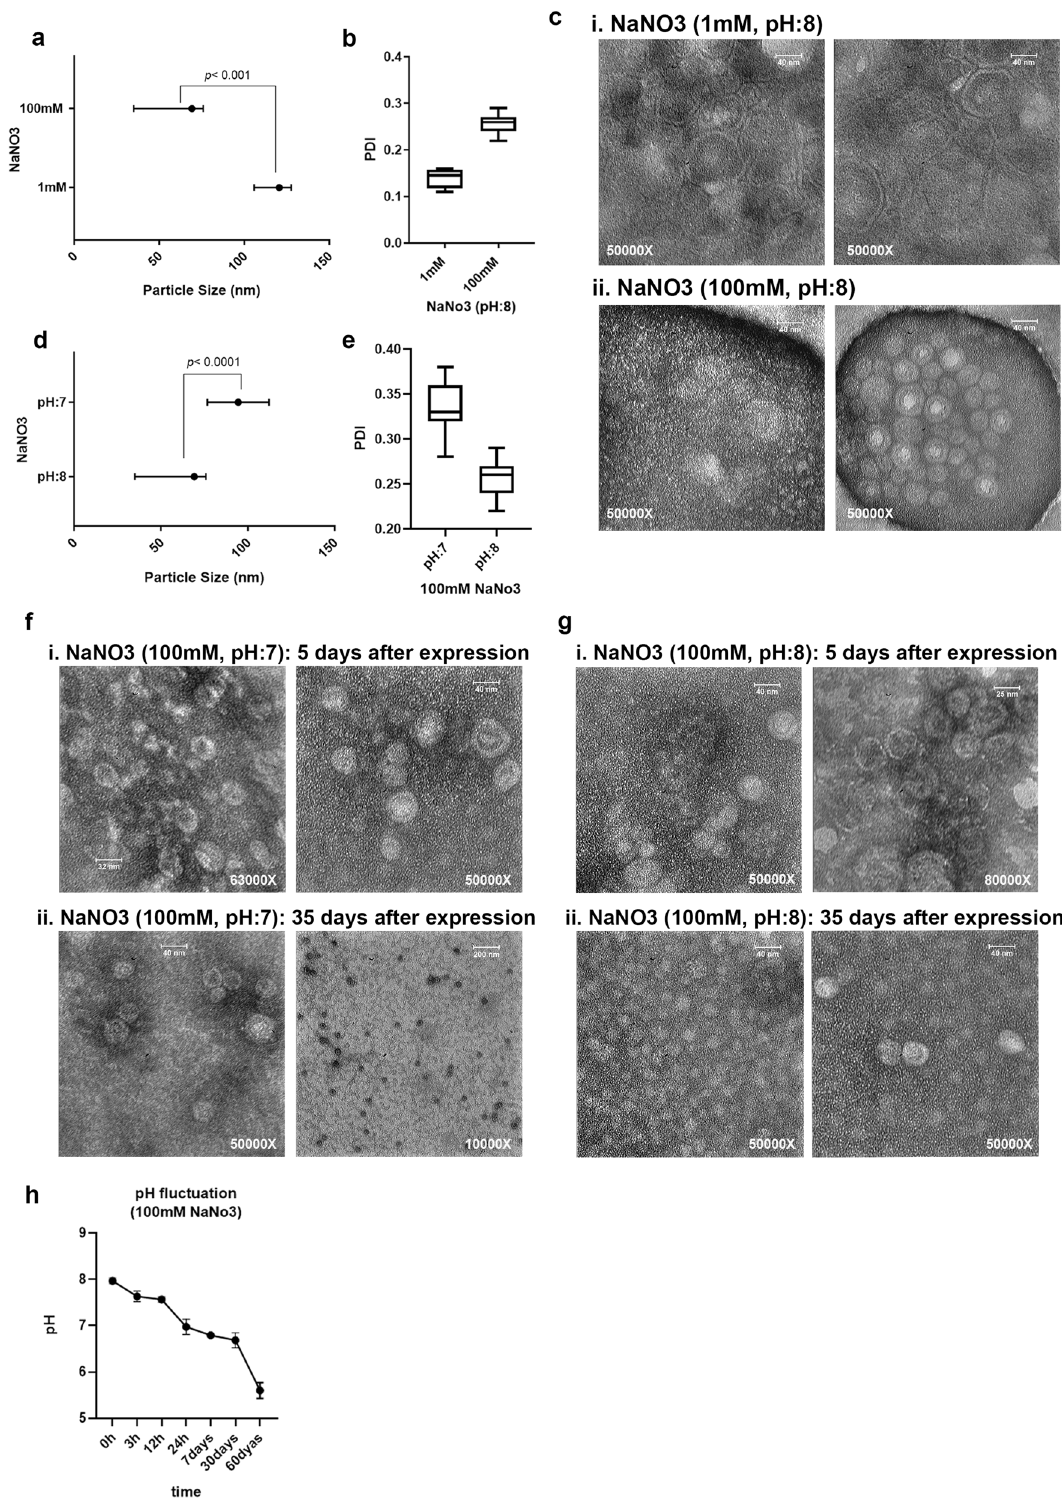
Figure 1. NaNO3 solution is the optimized NaNO3 solution for VLP purification during the PEG precipitation method. ( a ) The particle size of MS2 VLPs produced in 1 mM and 100 mM NaNO3 solution (pH:8). Results are shown as median with range, p < 0.001. ( b ) Polydispersity Index (PDI) shows the homogeneity of VLPs in different NaNO3 concentrations. ( c ) Verification of size and shape of VLPs by TEM. Images were taken from different parts of slides, confirming the differences in shape and size. i) VLPs in 1 mM NaNO3 solution ii) VLPs in 100 mM NaNO3 solution (pH:8). ( d ) The particle size of MS2 VLPs in 100 mM NaNO3 solution (pH:7 and 8). Results are expressed as median with range, p < 0.0001. ( e ) Polydispersity Index (PDI) of VLPs in different pH: 7 and 8. ( f , g